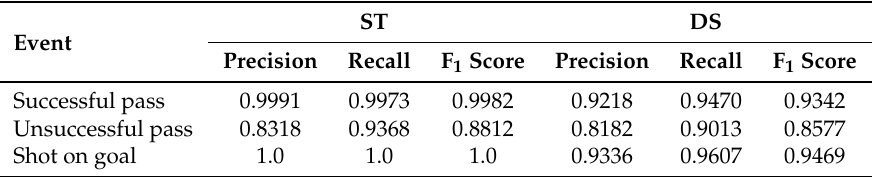
Table 5. Accuracy of event